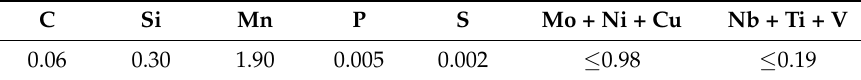
Table 1. Chemical compositions of the test steel (wt